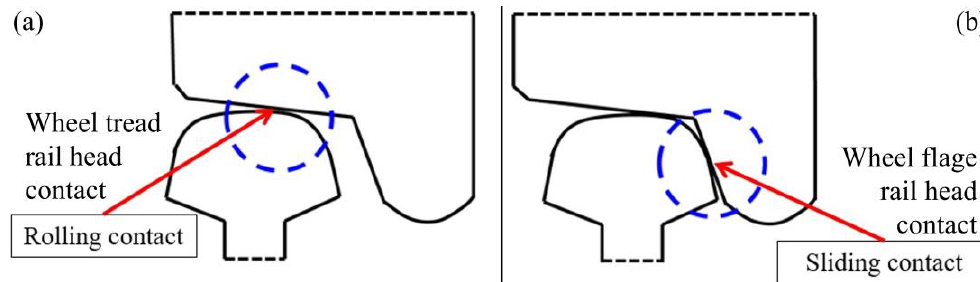
Figure 1. Rail track and wheel contact.